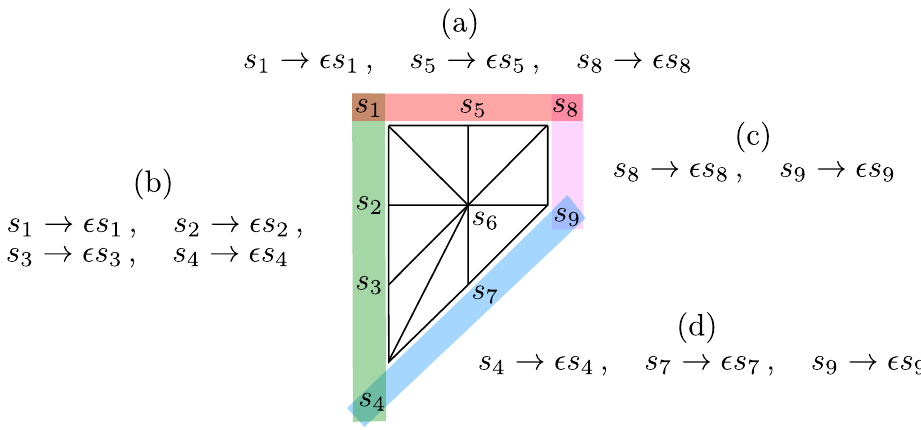
Figure 1 . The weak coupling limits for toric hypersurfaces can be constructed by scaling with (cid:15) all base sections along a line on the dual associated polytope while leaving the other base sections invariant. The polytope F 3 has four weak coupling limits associated to the facets of its dual polytope. There are two inequivalent weak couplings from the type IIB perspective as the limits (a) and (d), as well as (b) and (c) are equivalent because they produce the same D-brane